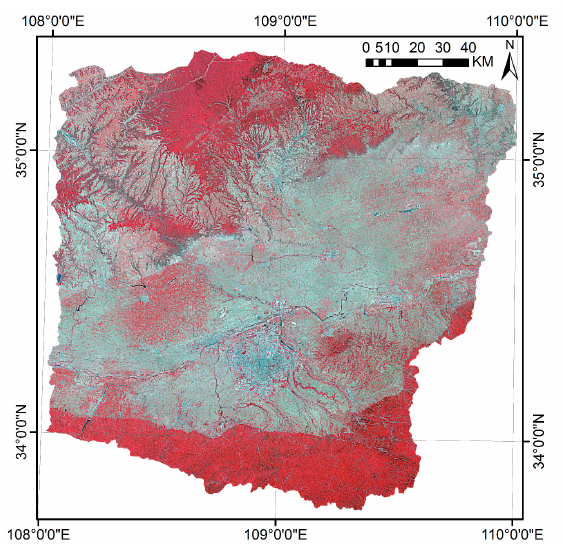
Figure 7. The location of the test area (Xi’an City, Shanxi Province, China) and its corresponding of Landsat TM image (NIR-red-green